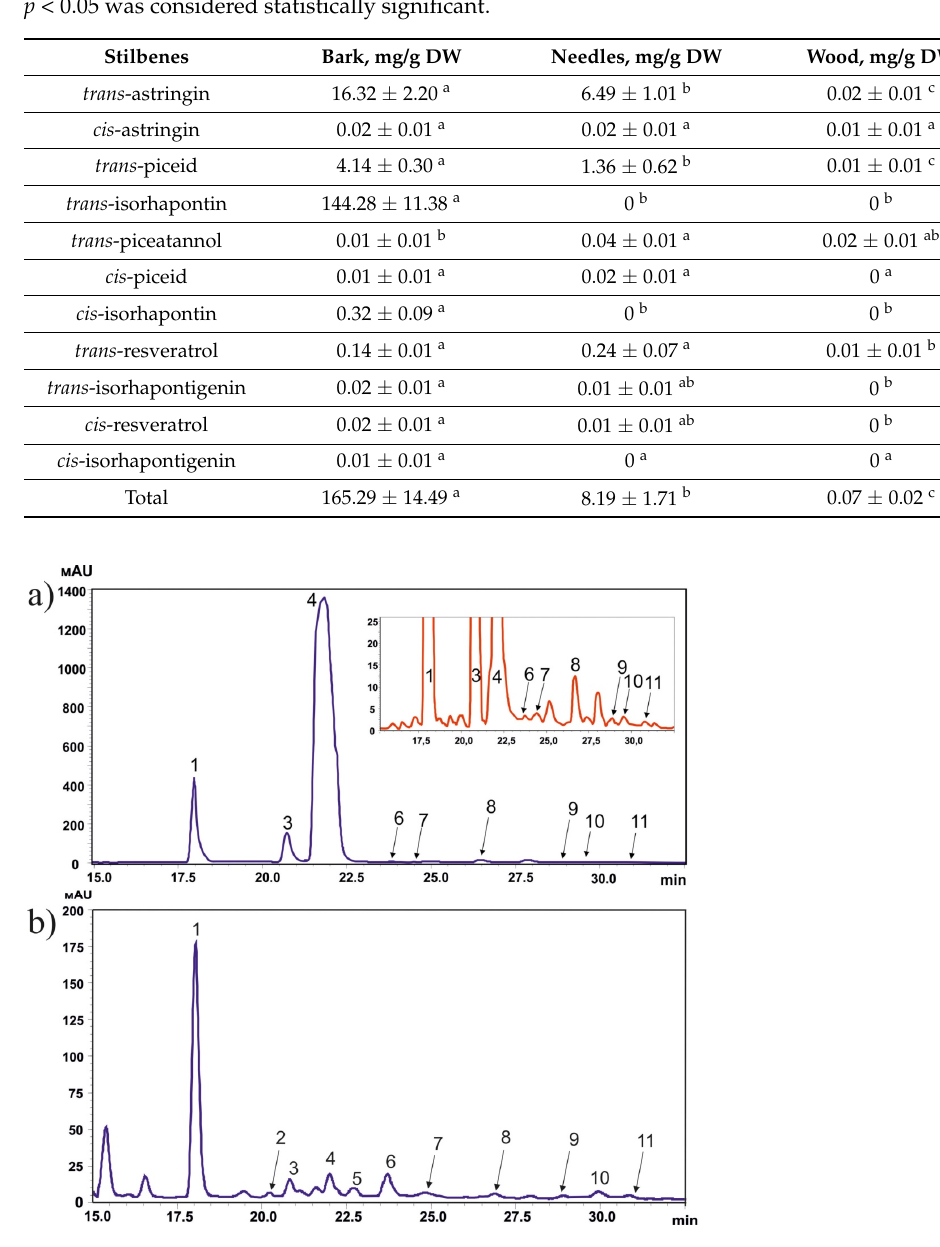
Figure 1. Comparison of HPLC-UV chromatographic profiles for the methanolic extracts of spruce bark ( a ) and needles ( b ) recorded at 310 nm. Spruce bark and needles were collected in winter. Trans -astringin (1, retention time 18.0 min), cis -astringin (2, 20.2 min), trans -piceid (3, 20.8 min), trans -isorhapontin (4, 21.9 min), trans -piceatanol (5, 22.6 min), cis -piceid (6, 23.9 min), cis -isorhapontin (7, 24.5 min), trans -resveratrol (8, 26.5 min), trans -isorhapontigenin (9, 28.8 min), cis -resveratrol (10, 29.7 min), cis -isorhapontigenin (11, 20.2